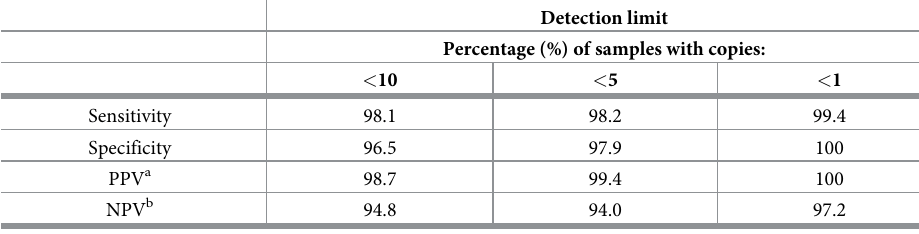
Table 7. Performance evaluation of the MoCO